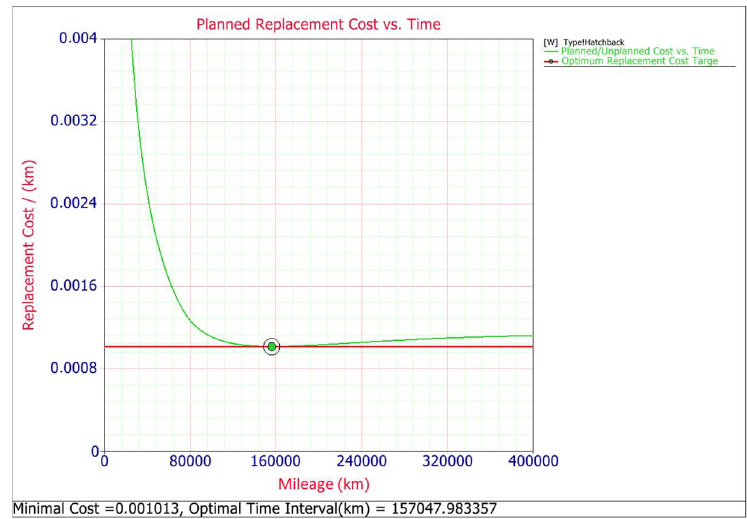
Figure 8. Planned replacement cost for hatchback.